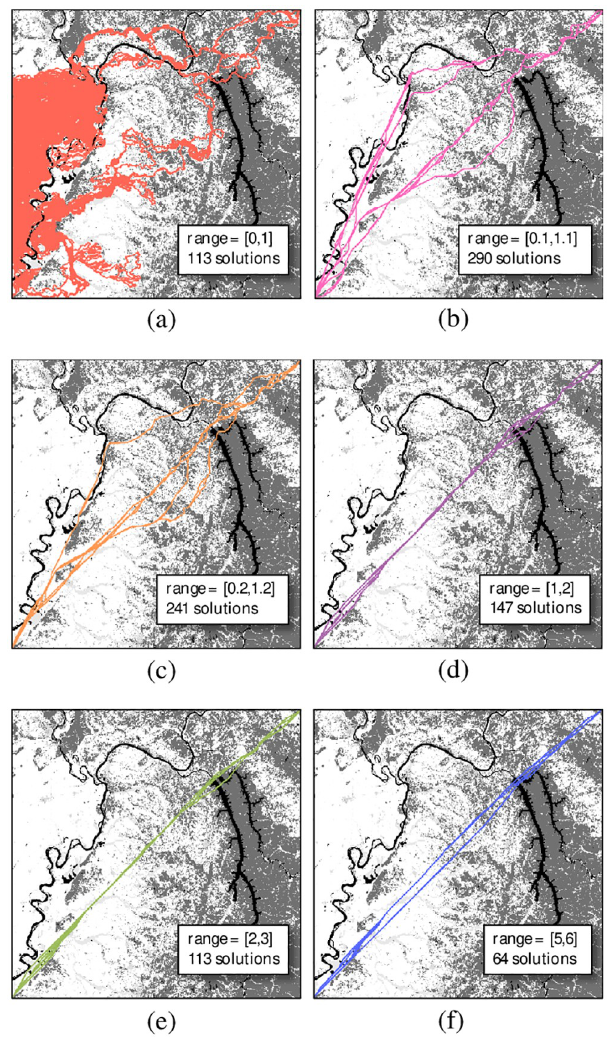
Fig 8. Decision space solutions for a constant amplitude while varying C min to the following ranges: (a) [0,1]; (b) [0.1,1.1]; (c) [0.2,1.2]; (d) [1,2]; (e) [2,3]; and (f) [5,6].